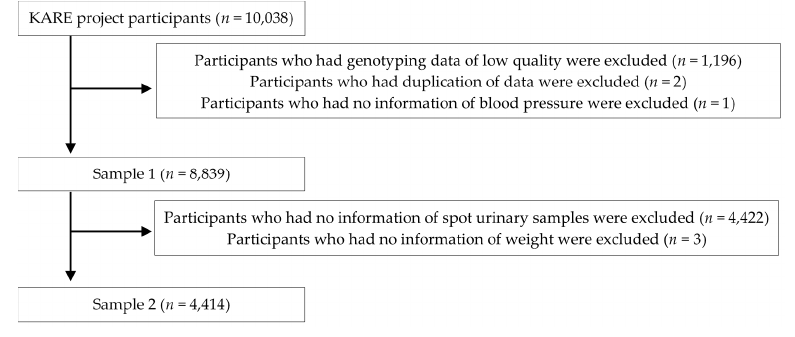
Figure 1. Selection of study participants.